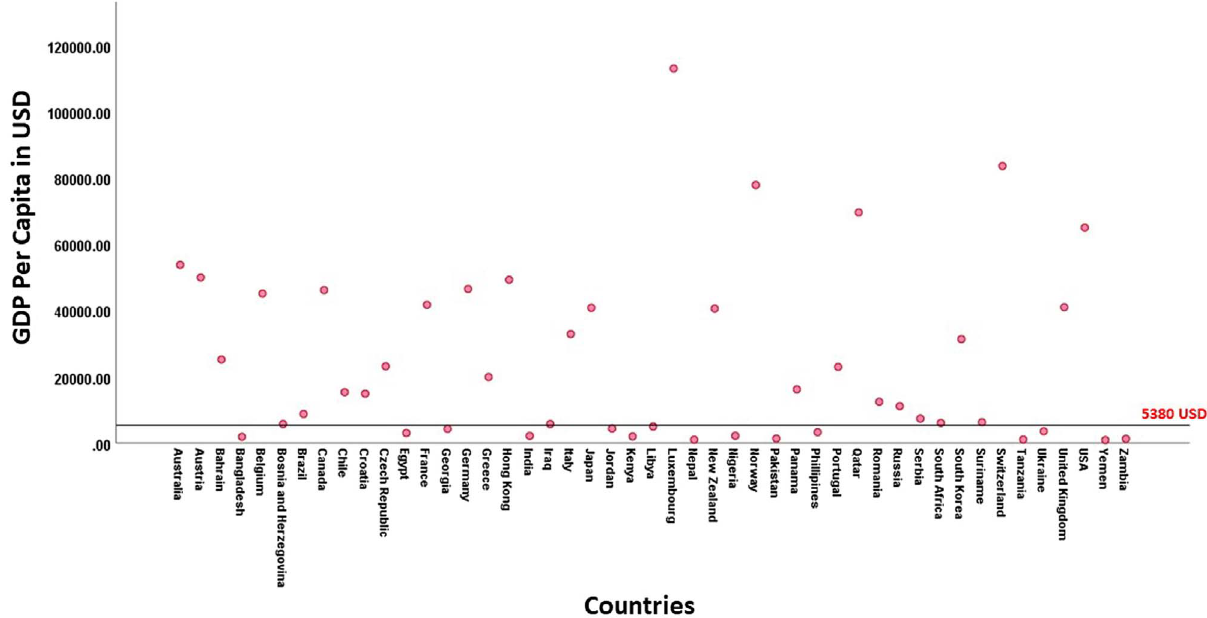
Figure 1. The gross domestic product (GDP) of the countries from which the study ’ s surgeon population belonged. The cut-off GDP was $5380 shown by the black line. Table 1. Demographic details of surgeons.